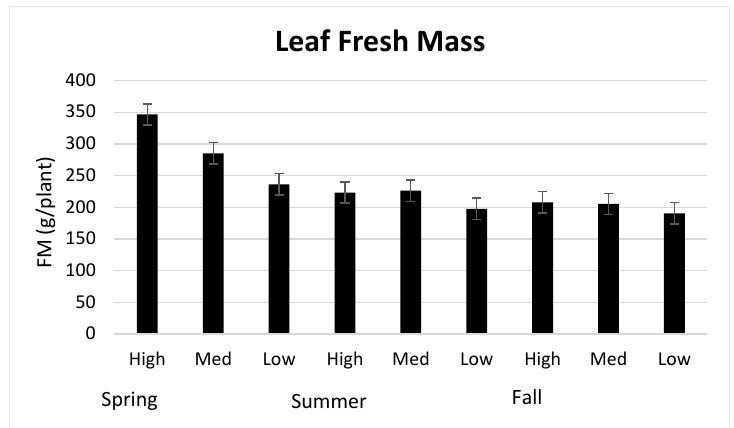
Figure 3. The effect of cultivar on greenhouse lettuce stem diameter. The standard error of the mean was: Stem diameter ± 0.23.